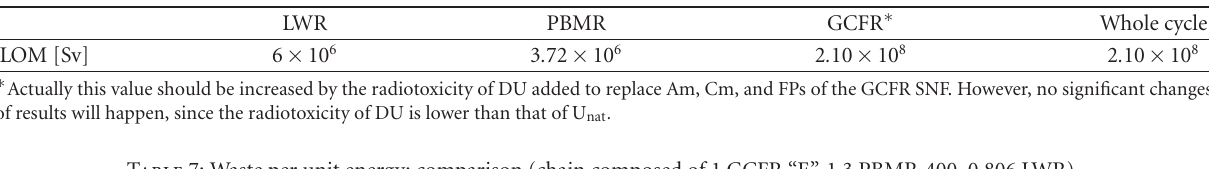
Table 6: LOM for SNF of the considered reactors.